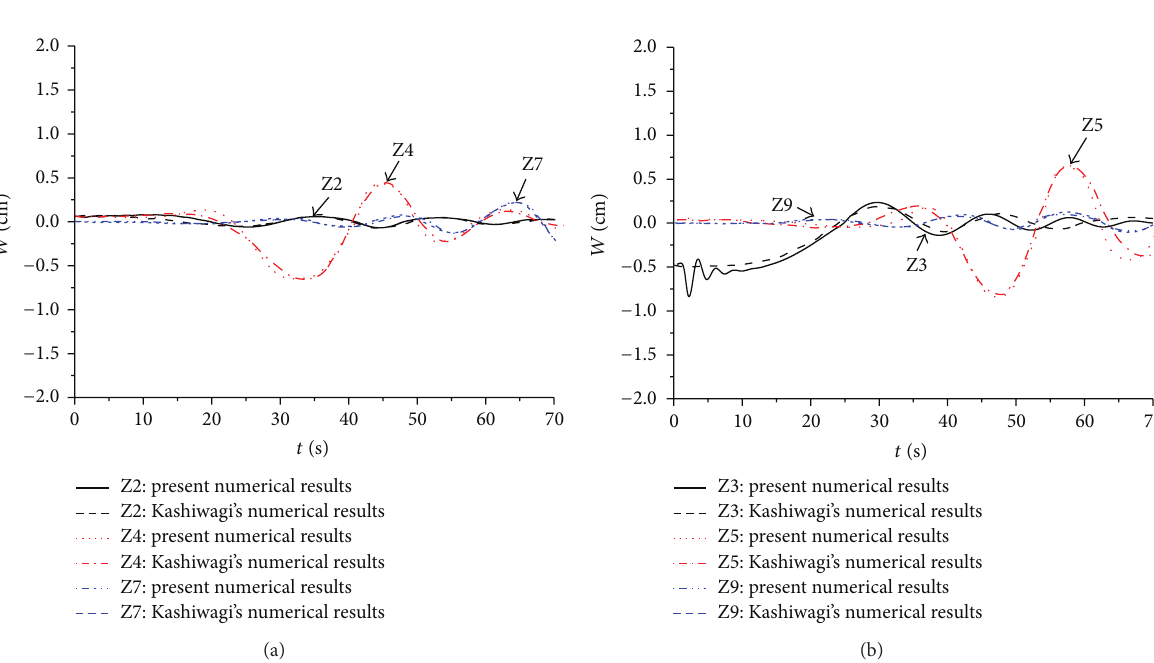
Figure 13: (a) The vertical displacement of locations of airplane. (b) The path of the landing run.